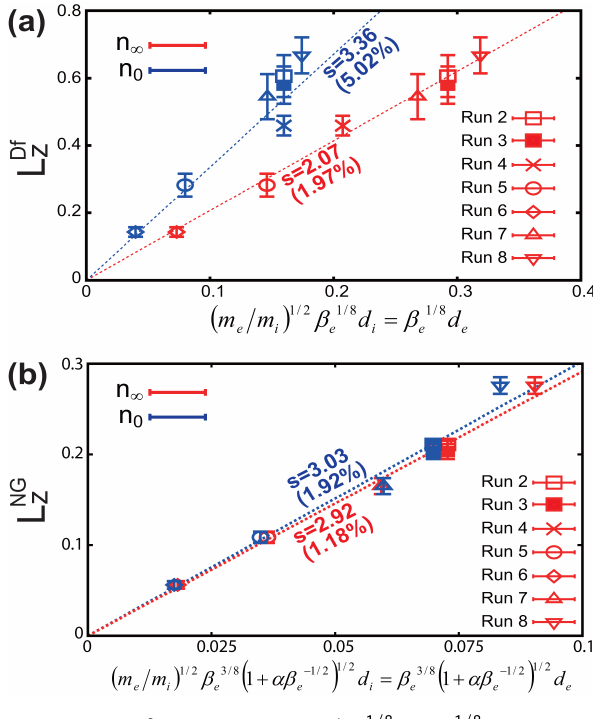
Figure 6. L Df z versus (m e /m i ) 1 / 2 β 1 / 8 e d i = β 1 / 8 e d e (a) , and L NG z versus (m e /m i ) 1 / 2 β 3 / 8 e where α = 0 . 15 (b) normalized by d i0 for Runs 2–8. n ∞ (red), and n 0 (blue) are examined to calculate d e and d i . Each value is the averaged one during a quasi-steady period where | d A y / d t | > 0 . 75 | d A y / d t | max . Error bars show the standard deviation, and the dashed lines indicates the regression lines with slopes and standard